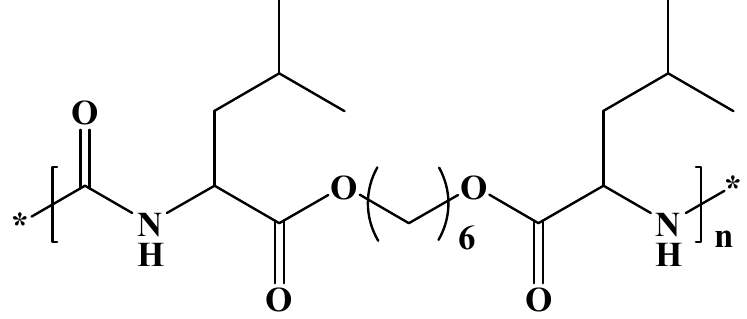
Figure 1. Chemical structure of PEU 1L6.